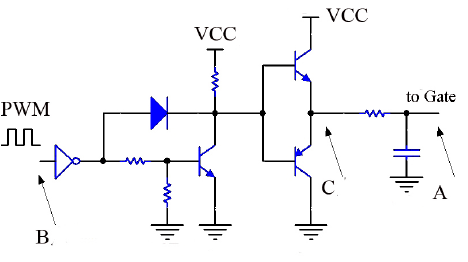
Figure 3. MOSFET gate drive.